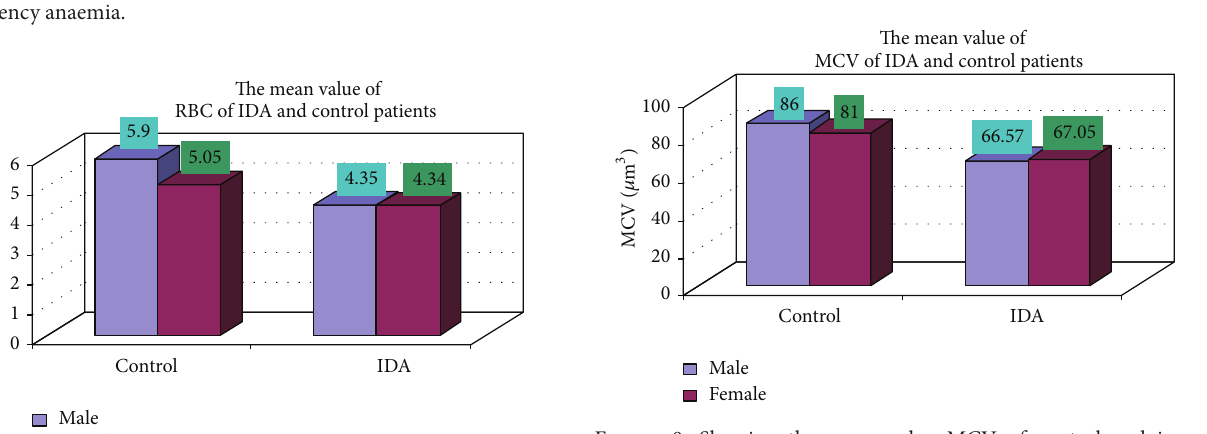
Figure 8: Showing the mean value MCV of control and iron deficiency anaemia. Table 1: Mean biochemical parameters of IDA and control. Biochemical